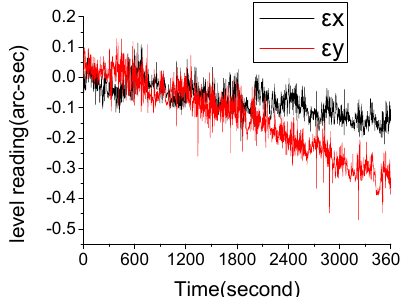
Figure 11. Stability data of the proposed precision level.